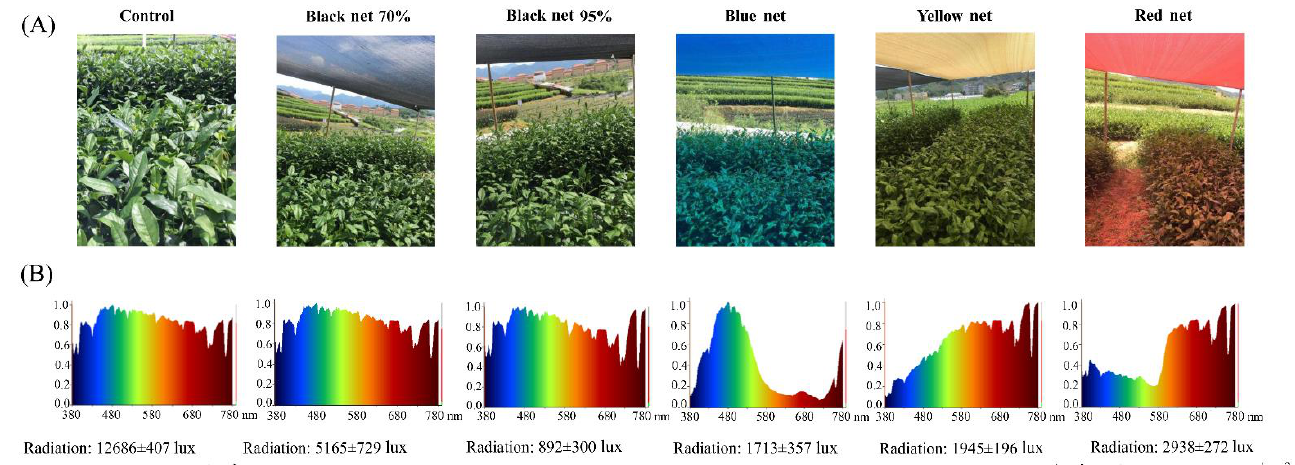
Figure 1. Different shade treatments on the growth of tea plants. ( A ) tea plants under different shade nets; ( B ) visible spectrum, light intensity, and UV intensity.